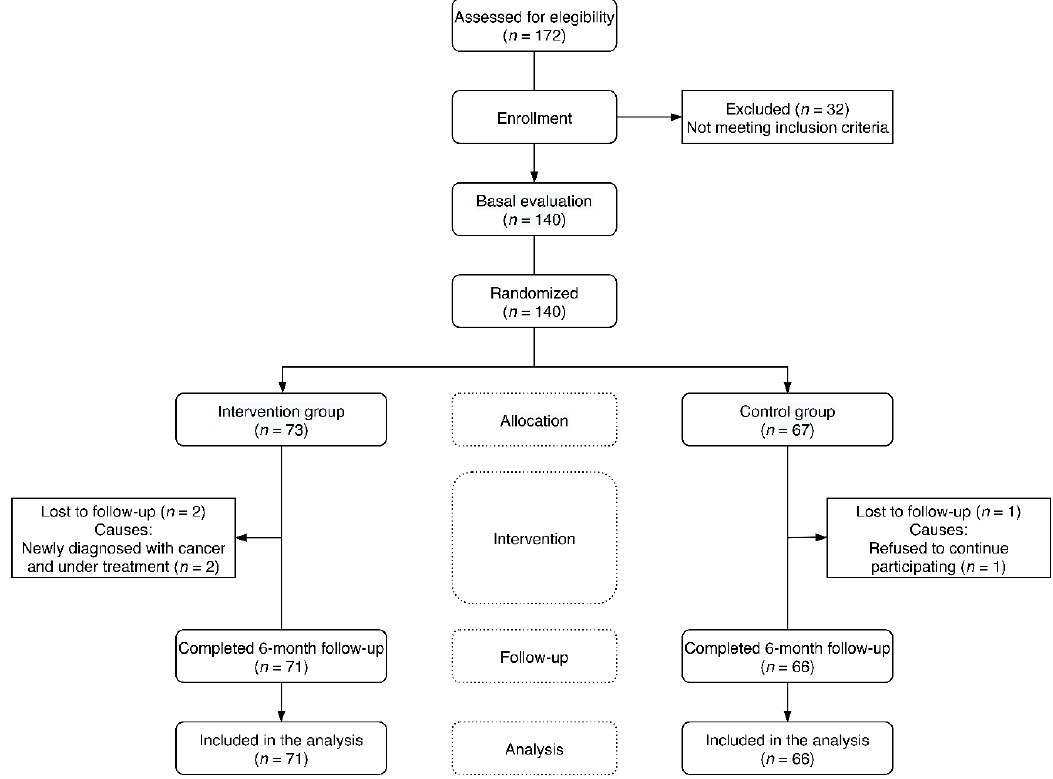
Figure 1. Flow diagram of postmenopausal women through the study.